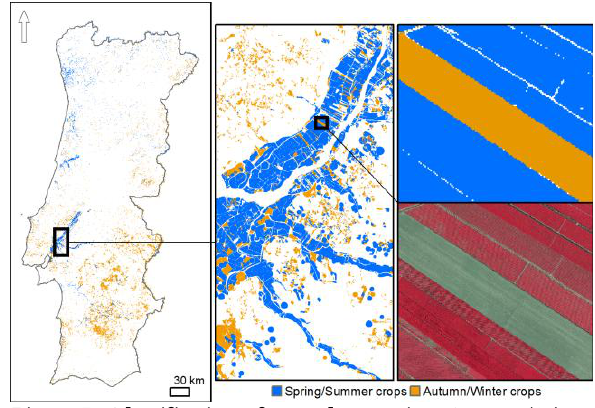
Figure 7. Classification of annual crops into Autumn/Winter crops and Spring/Summer